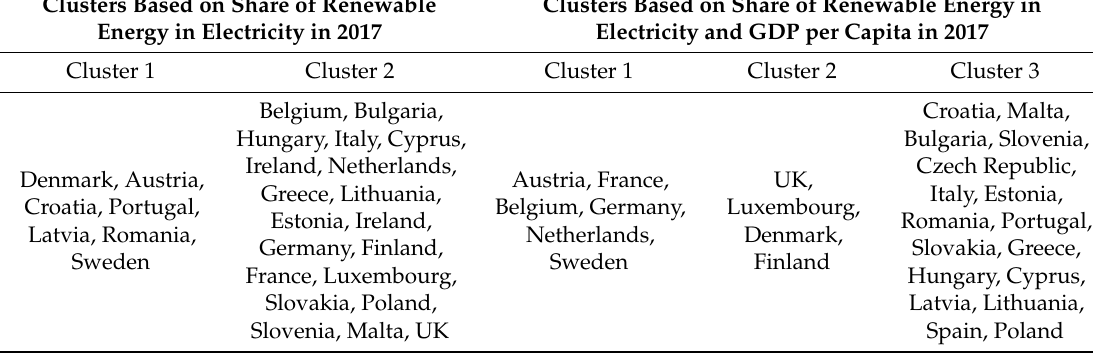
Table 4. Groups of EU countries according to share of renewable energy in electricity and GDP per capita in 2017. Clusters Based on Share of Renewable Clusters Based on Share of Renewable Energy in Energy in Electricity in 2017 Electricity and GDP per Capita in 2017 Cluster 1 Cluster 2 Cluster 1 Cluster 2 Cluster